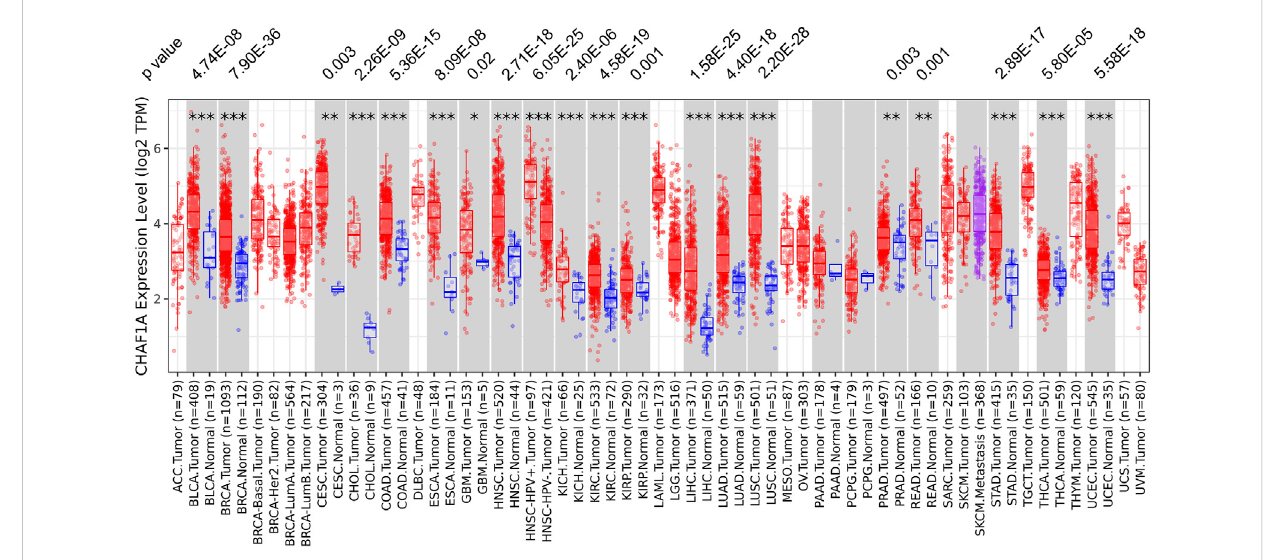
FIGURE 1 The expression of CHAF1A is signi fi cantly higher in malignant tissues compared with normal tissues in various cancer types. In TIMER 2.0 database, CHAF1A is signi fi cantly highly expressed in 20 types of malignancies compared with normal tissues. The statistical signi fi cance was annotated by stars (*: p < 0.05; **: p < 0.01; ***: p <